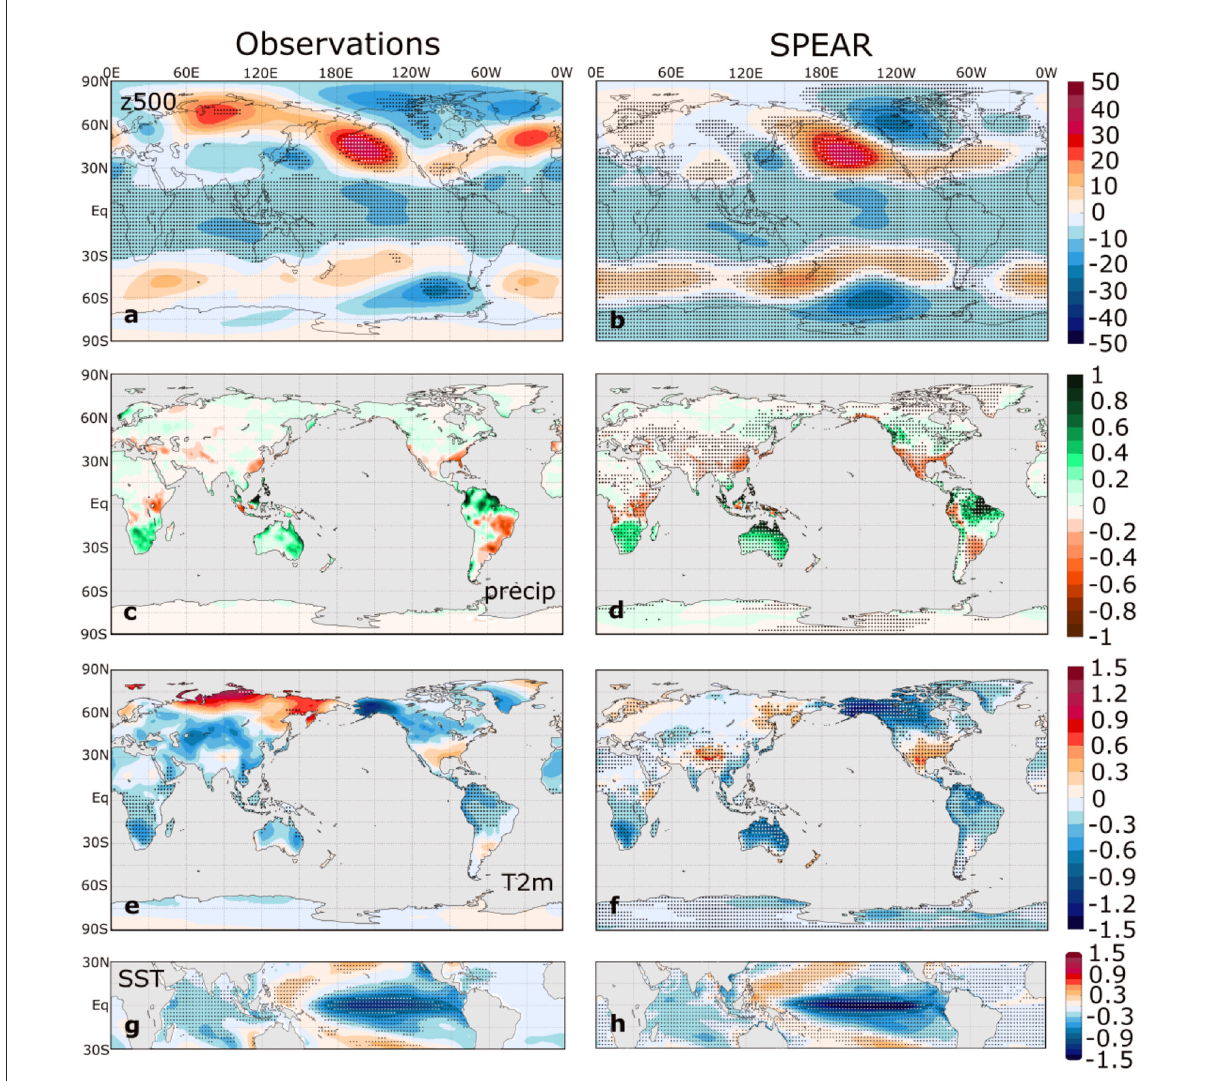
FIGURE2 As in Figure 1 but for La Niña